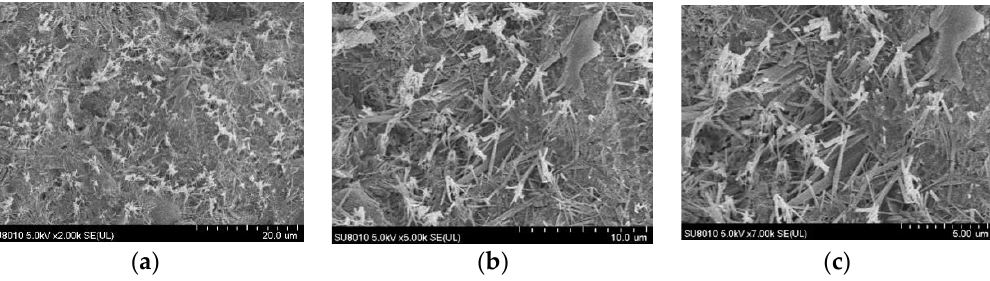
Figure 11. SEM images of concrete before freeze – thaw cycles. ( a ) 2000 ×. ( b ) 5000 ×. ( c ) 7000 ×.